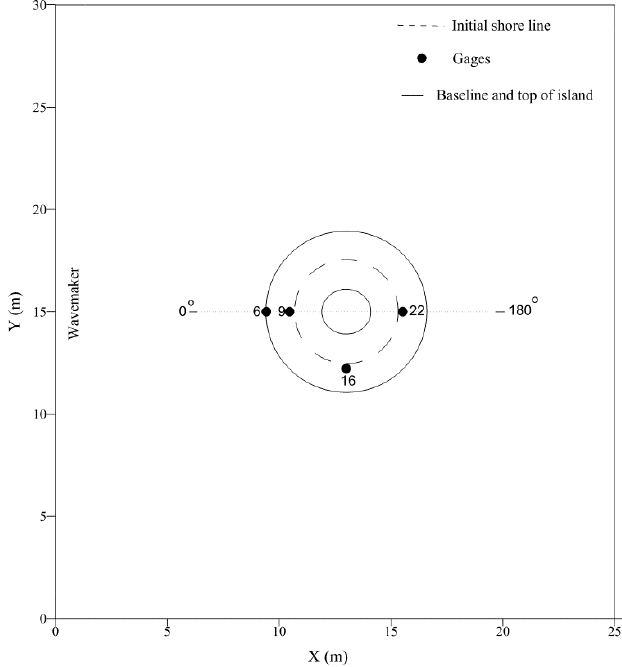
Figure 2. Schematics of the experimental set up for solitary wave interactions with a conical island.